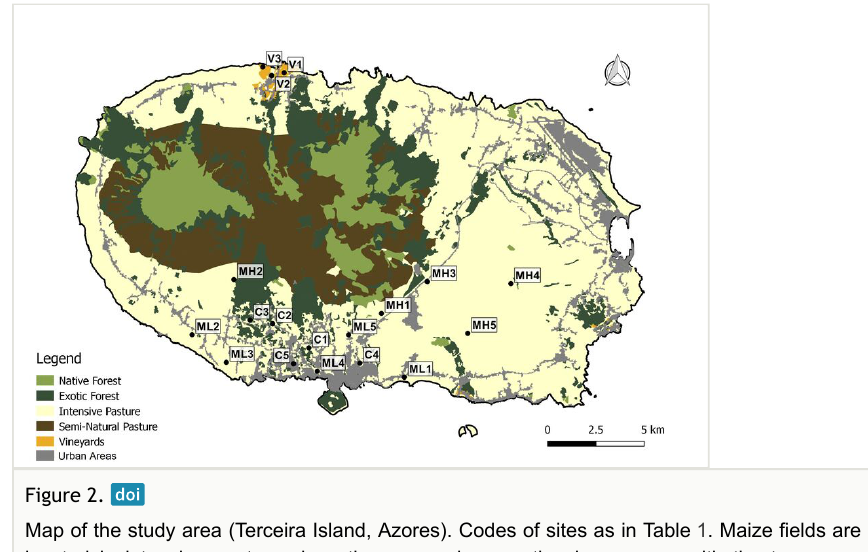
Map of the study area (Terceira Island, Azores). Codes of sites as in Table 1. Maize fields are located in intensive pasture since they are only operating in summer, with the two crops usually grown in rotation (Land-use data extracted from Cruz et al.